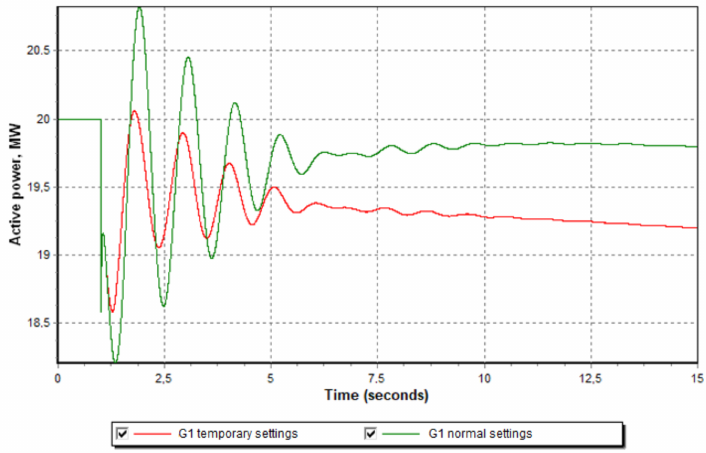
Figure 18. Response of generator (G1) to SC